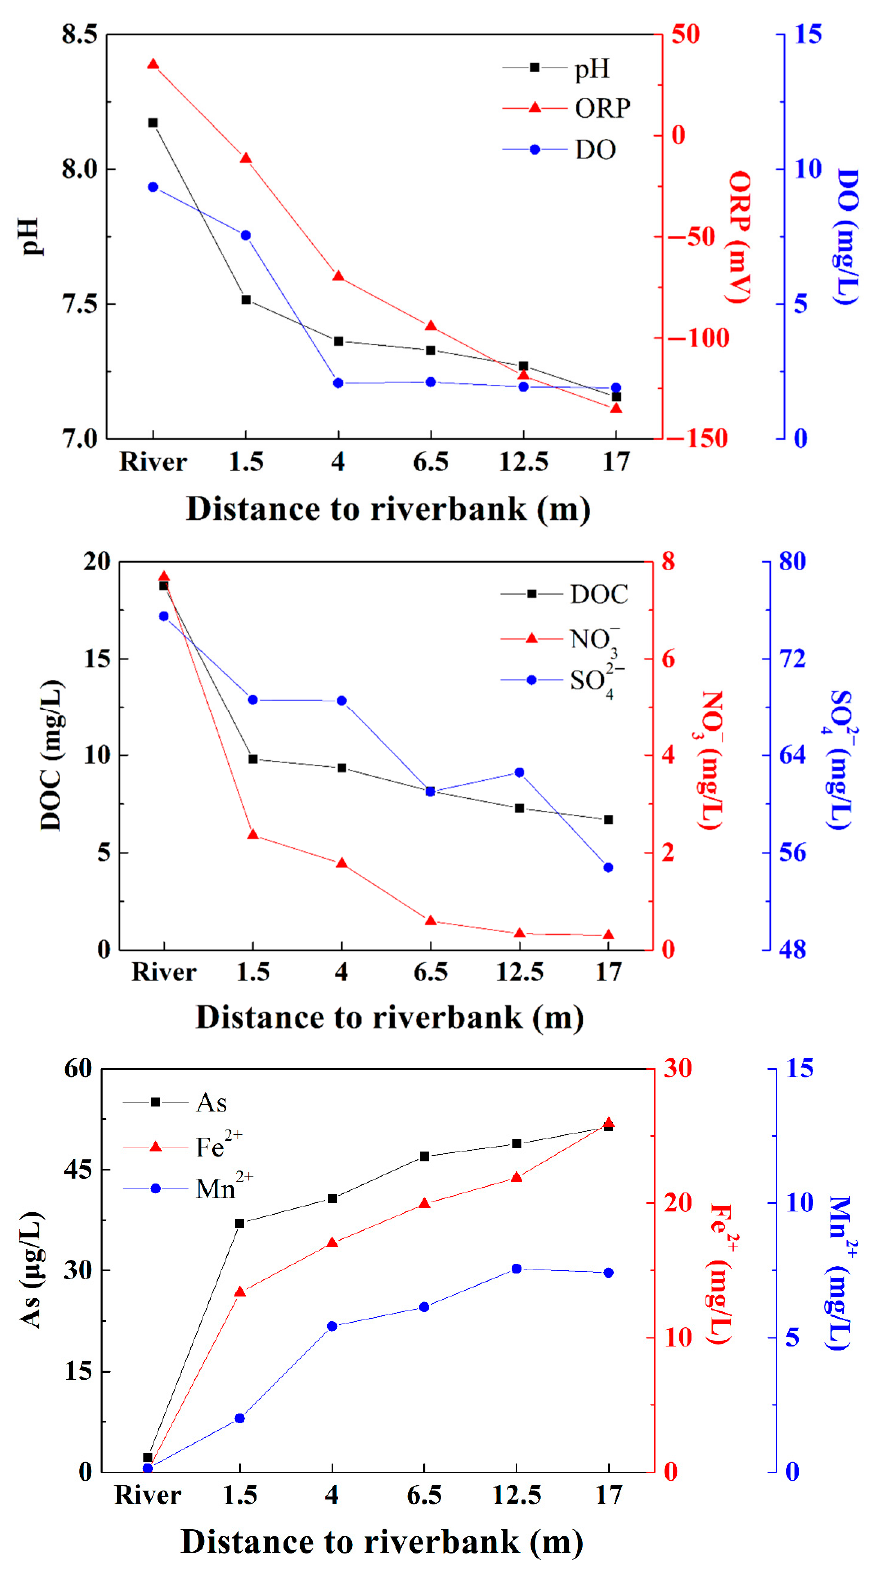
Figure 2. Variations in hydrochemical parameters along the groundwater flow